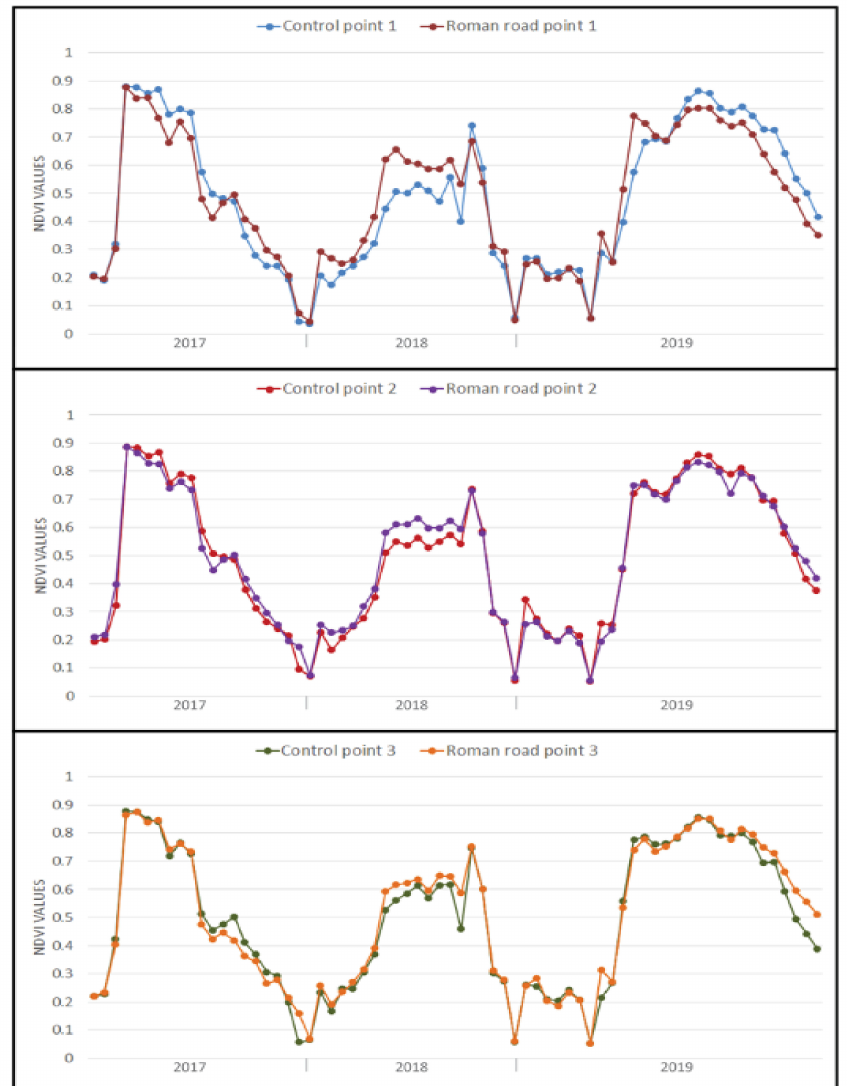
Figure 17. NDVI values derived from Sentinel–2 imagery acquired between 2017 and 2019, for the six points located within the agricultural parcel crossed by the Roman road from the Cigm ă u fort to the baths in Geoagiu–B ă i (the three pairs of points are illustrated in Figure